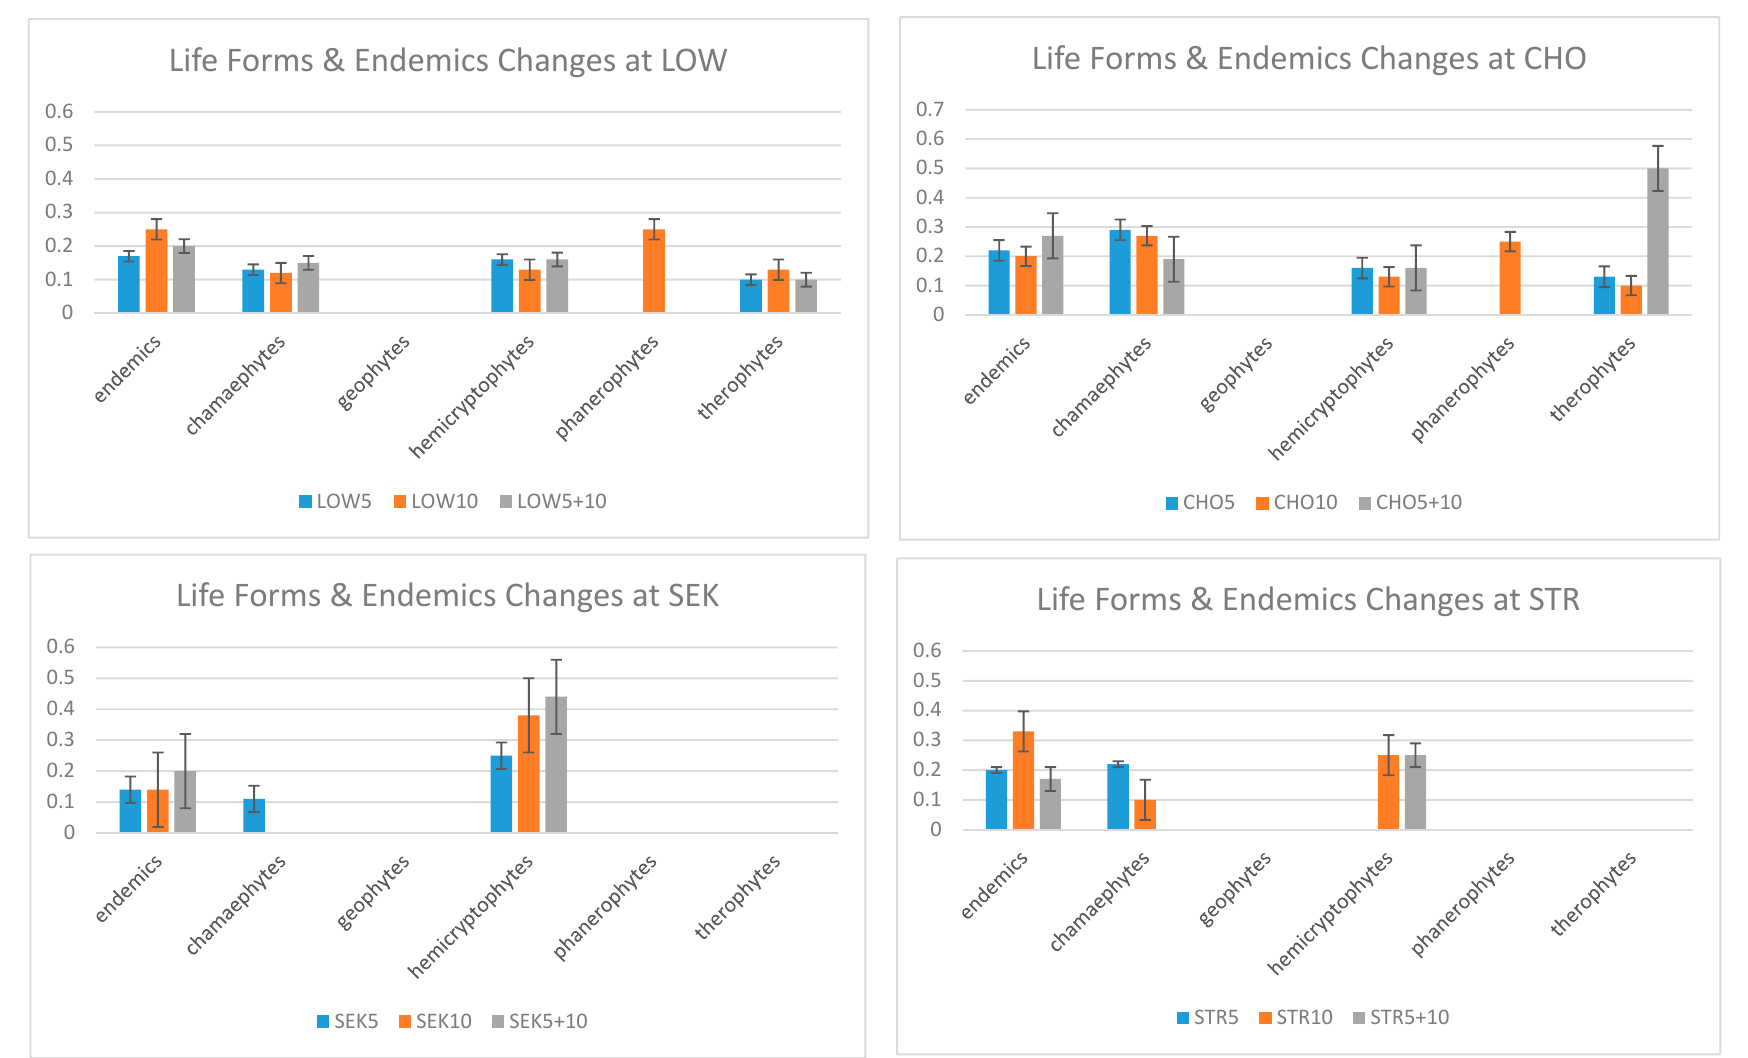
Figure 2. Vegetation turnover over the two monitoring periods. LOW: low summit, CHO: Chorafas, SEK: South East Kakovoli, STR: Sternes.